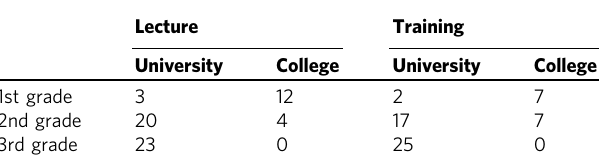
Table 3 Students ’ grades for whom parasitological